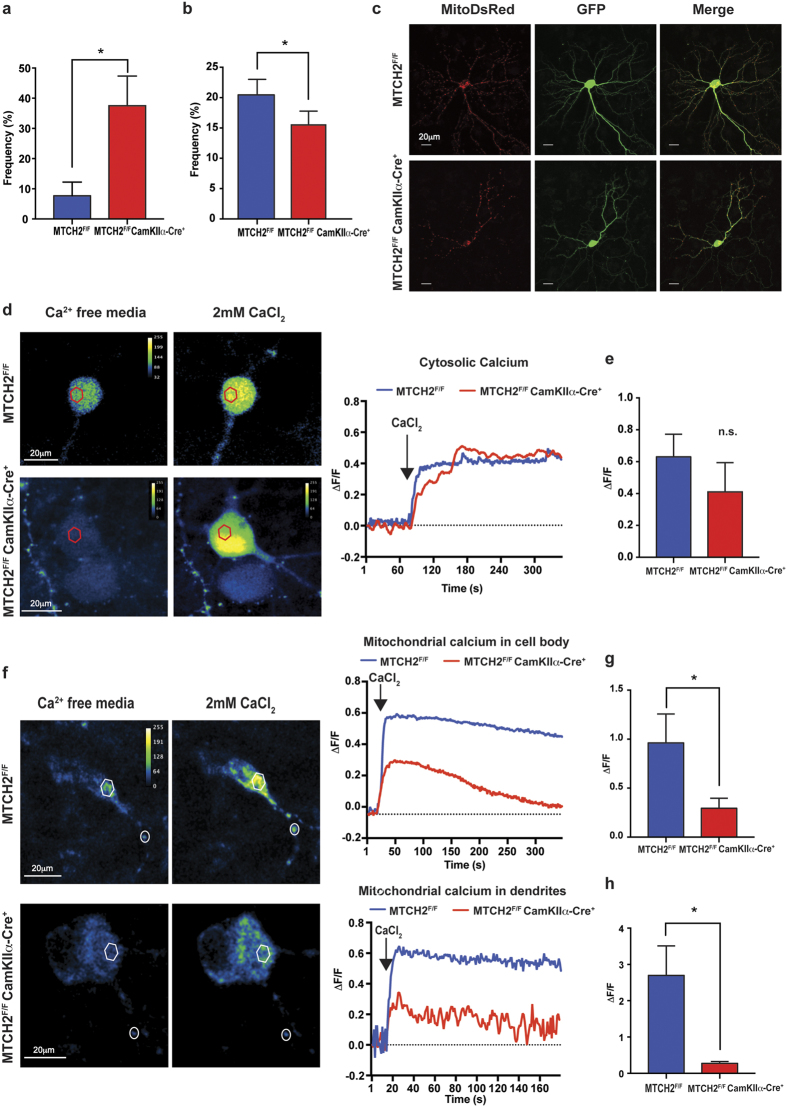
MTCH2F/FCamKIIα-Cre+ hippocampal neurons express a deficit in mitochondria motility and in mitochondria calcium handling.(a) Loss of forebrain MTCH2 decreases mitochondria motility: relative percentage of axons per cell where no movement was detected. Mean ± SEM (*p = 0.048; Unpaired t test with Welch’s correction). (b) Comparison of the percentage of motile mitochondria in MTCH2F/F versus MTCH2F/F
CamKIIα-Cre+ primary hippocampal neurons. Mean ± SEM (*p = 0.039; unpaired t test with Welch’s correction). (c) Mitochondrial distribution in primary hippocampal cells. Neurons were co-transfected with the mitoDsRed and GFP plasmids and imaged at div10 for mitochondria distribution (left panels) and neuronal morphology (GFP; middle panels). The right panels are a merge of the left and middle panels. Scale bar, 20 μm. (d) No differences in cytosolic [Ca2+] regulation. Changes in cytosolic calcium were measured in primary hippocampal neurons by incubating the cells with Fluo-2AM. In the left panel, images of neurons displaying increase in fluorescence following addition of calcium into the bathing solution. Calcium addition to the Ca2+-free media (arrow, on the right panel) caused a rise in intracellular free [Ca2+] in both MTCH2F/F and MTCH2F/F
CamKIIα-Cre+ cells. The red hexagons on the left panels represent the region of interested (ROI) used to generate the graphs on the right. (e) Averages of relative maximal fluorescence intensity of neurons loaded with Fluo-2AM. Mean ± SEM (p = 0.39; n = 3–5 cells/genotype; 2 independent experiments). (f) Reduced mitochondrial calcium uptake in MTCH2F/F
CamKIIα-Cre+ primary neurons. Left panel: Images of neurons transfected with mitochondria mt-RCaMP calcium sensor in Ca2+ free media and following the addition of calcium into the bathing solution. Right panel: upper graph represents changes in calcium in mitochondria localized in the soma of the neurons (white hexagon in the left panel); lower graph represents changes in dendritic mitochondrial calcium (white circle in the left panel). (g) Averages of relative maximal fluorescence intensity of mitochondria expressing mt-RCaMP in the cell body. Mean ± SEM (*p < 0.05; n = 6–10 cells/genotype; 4 independent experiments). (h) Averages of relative maximal fluorescence intensity of mitochondria expressing mt-RCaMP in the dendrites. Mean ± SEM (*p < 0.05; n = 3–5 mitochondria per cell; n = 6–10 cells/genotype; 4 independent experiments).